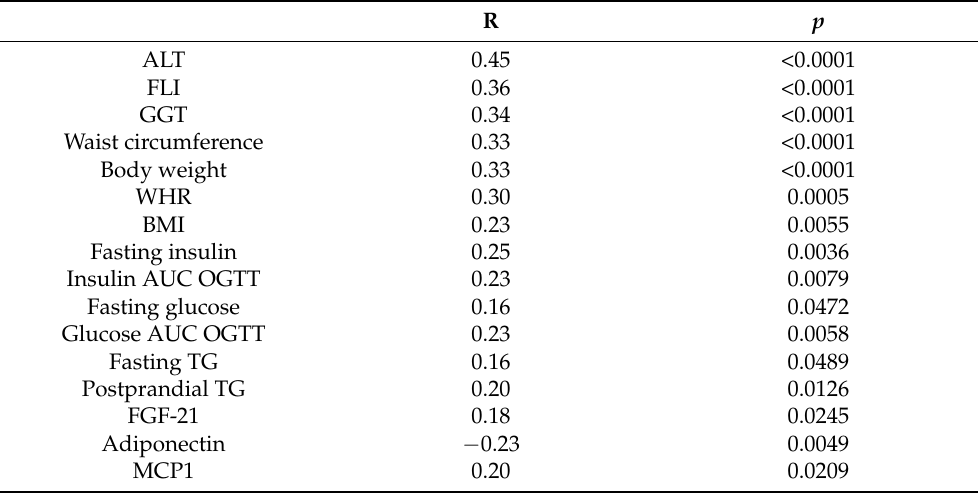
Table 3. Spearman rank correlation between cytokeratin-18 plasma levels and anthropometrics, liver markers and metabolic variables in the entire group of subjects participating in the study ( n = 151).